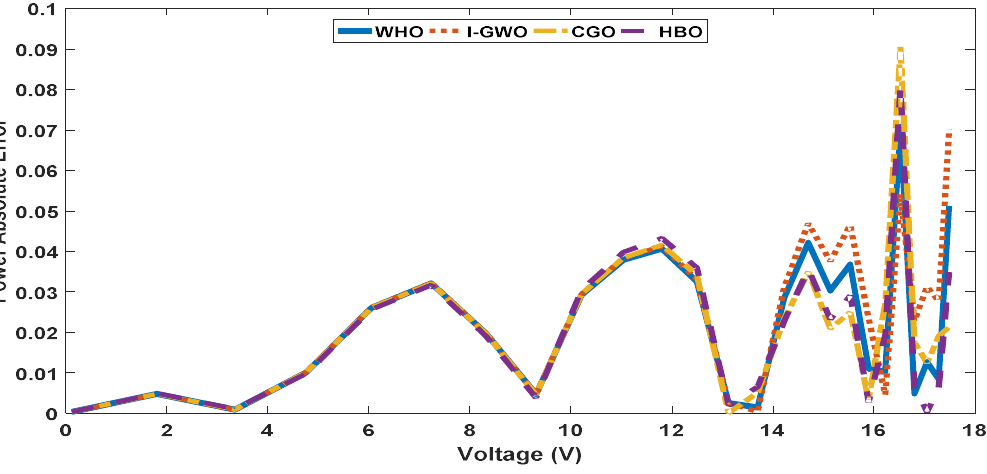
Figure 21. Power absolute error of all algorithms.